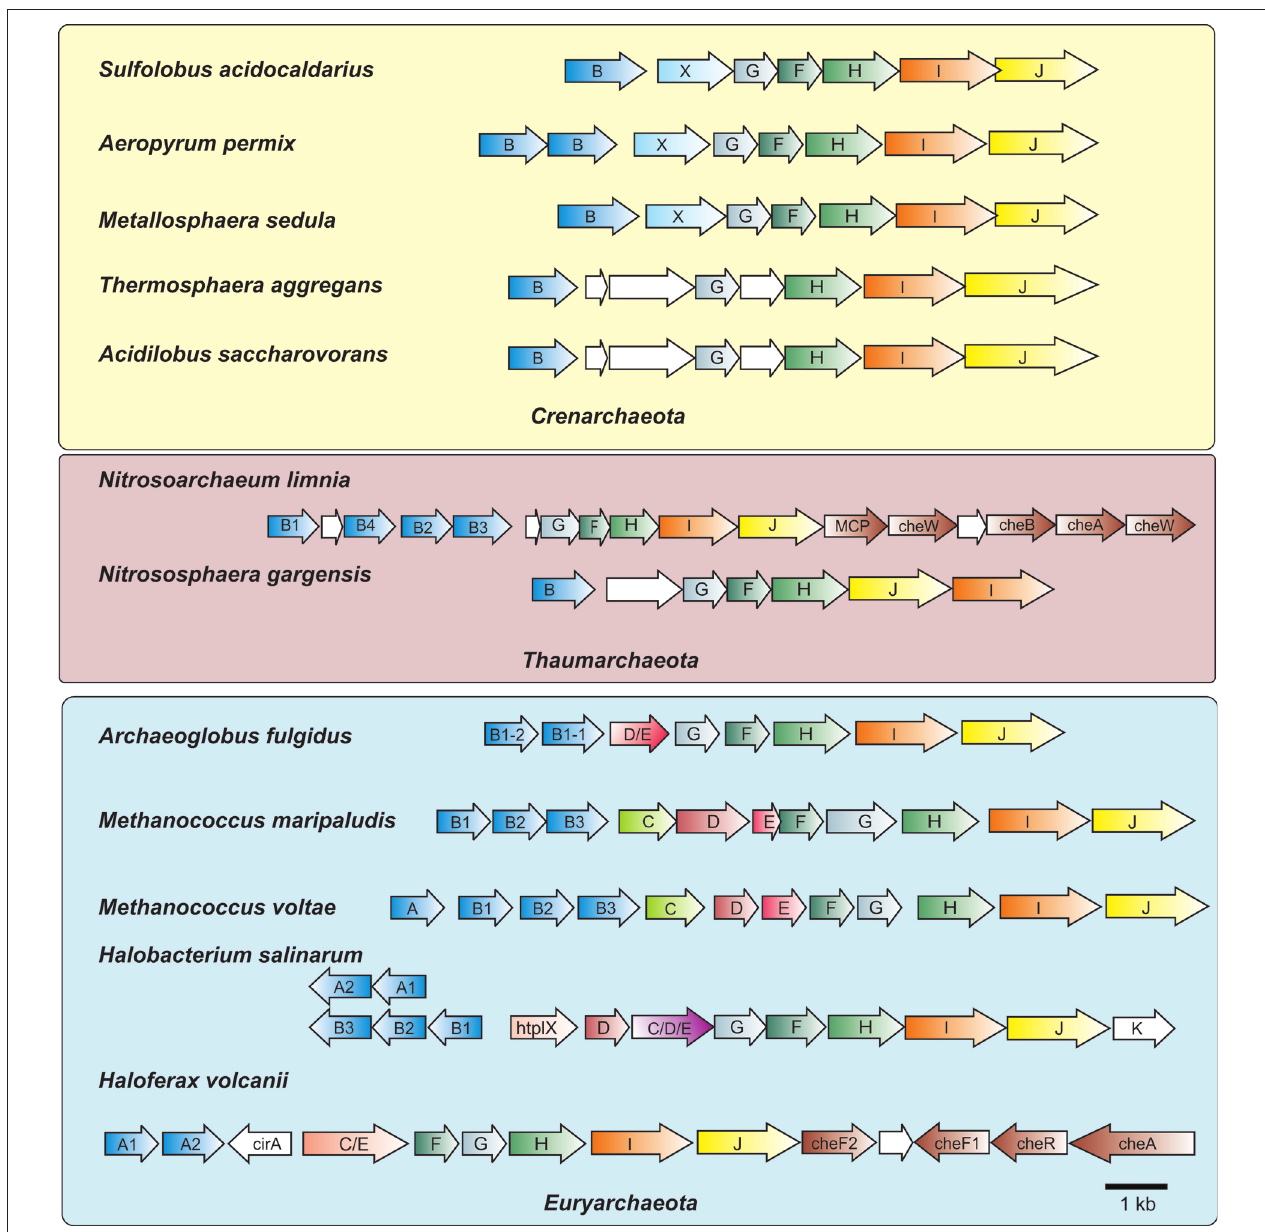
function are depicted in white. In the strain where chemotaxis genes are adjacent to the archaellum operon they are partially depicted. MCP, methyl accepting chemotaxis protein; che genes, genes encoding parts of the chemosensory system; htrl, methyl accepting